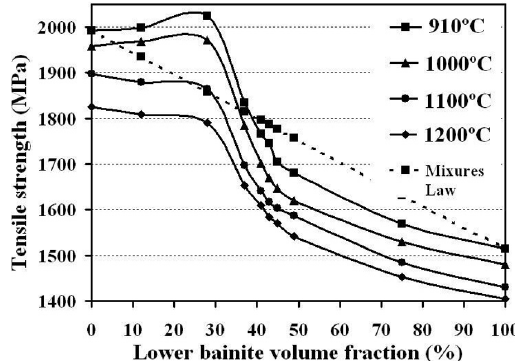
Figure 5. Variation of tensile strength with amount of the lower bainite for various austenitizing temperatures. Mix is yield strength of lower bainite - martensite Where σ y B are yield strength of mixed microstructure, σ yM and σ y martensite and lower bainite microstructure,